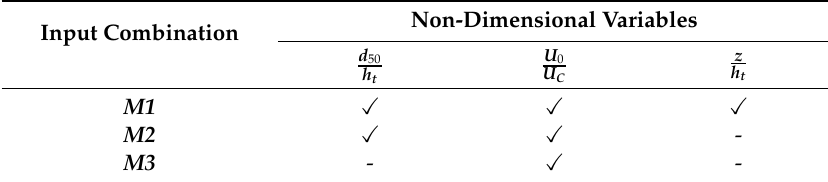
Table 3. Input parameters combination for prediction of scouring depth downstream of weirs.